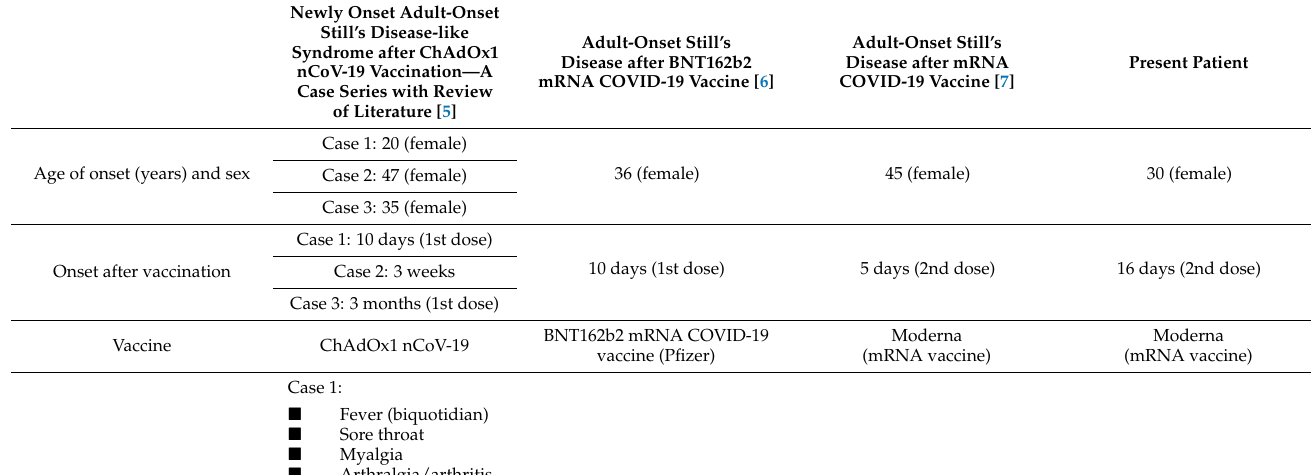
Table 1. Comparison of various cases reported in the literature. Several reported cases were studied to compare similarities and differences. The details of cases such as the age of onset, onset after vaccination, types of vaccine received, symptoms, diagnostic criteria used, and treatment are listed above; meanwhile, every symptom of the case above was summarized into a list for a clearer